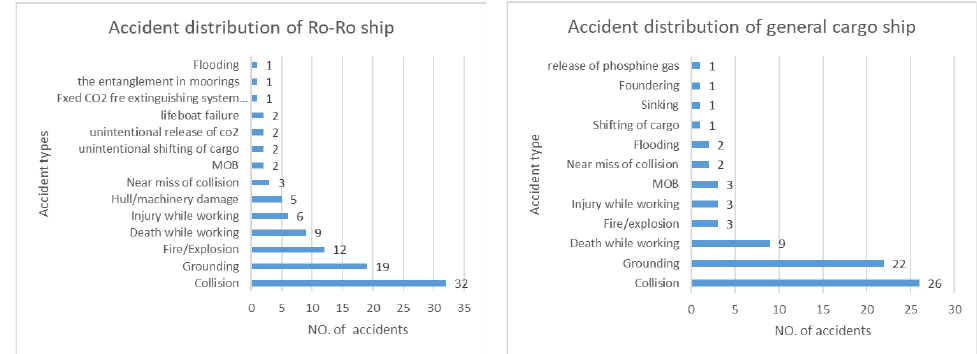
Figure 7. Other accidents distribution by vessel type.